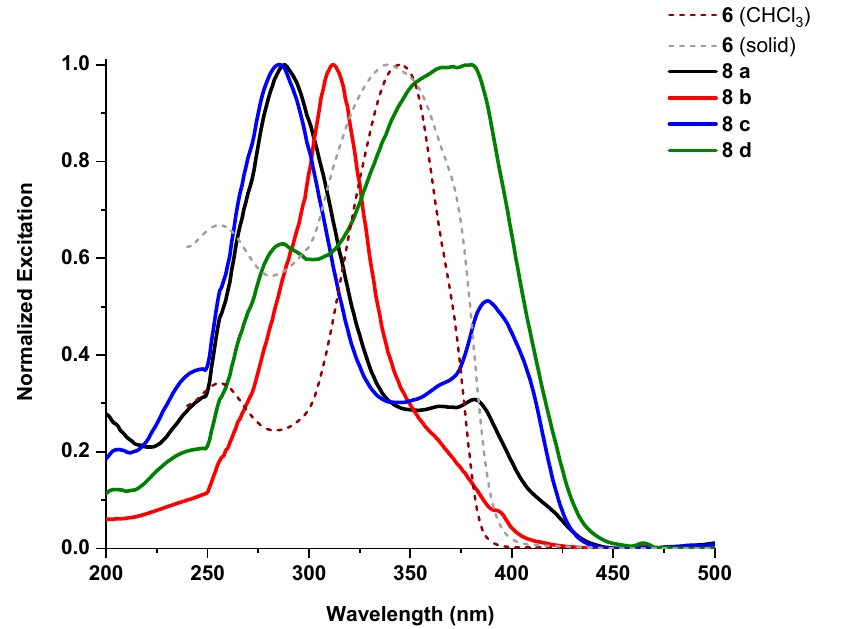
Figure 14. Normalized absorption spectra of polymer 6 in solution and in the solid state and